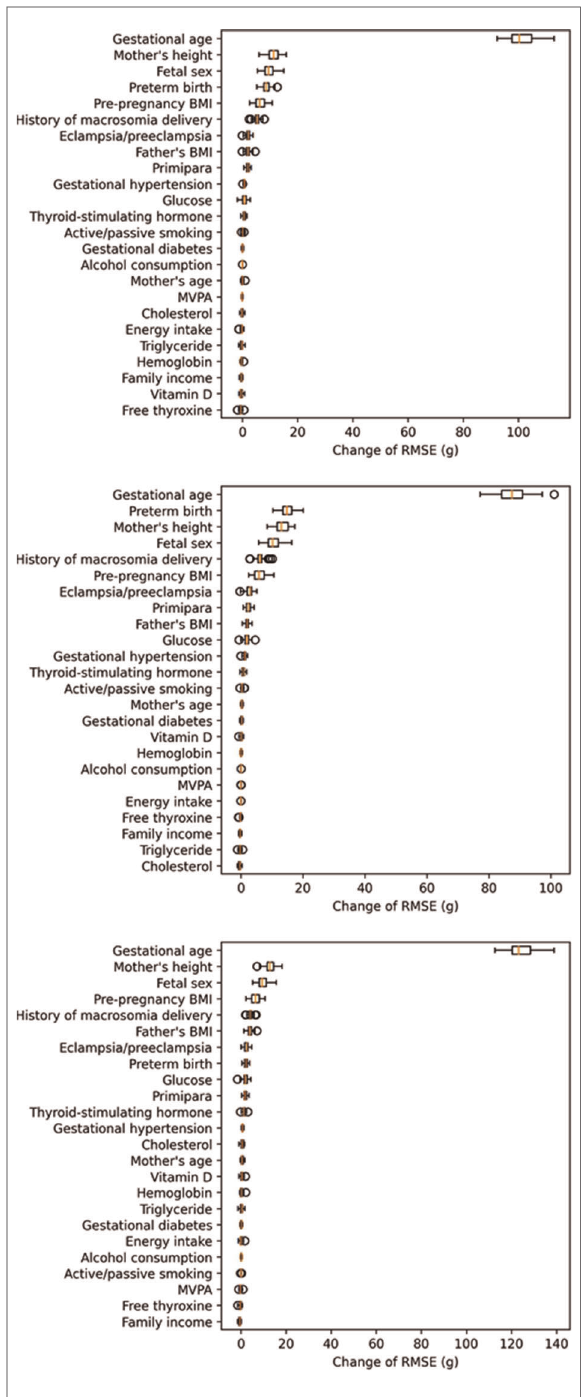
FIGURE 2 Permutation importance of predictors in the voting ensemble for regression (top fi gure), linear regression (middle fi gure), and SVR (bottom fi gure) models (calculation of permutation importance score was repeated for 50 times, and the box-plot for each predictor showed the distribution of 50 permutation scores).